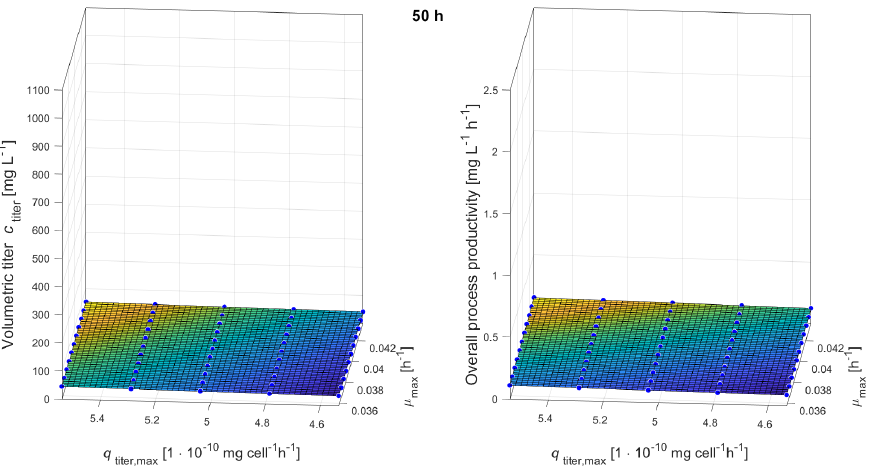
Figure A4. Response surfaces showing the impact of maximum growth rate and maximum production rate on volumetric titer and overall process productivity after 50 hours in production.